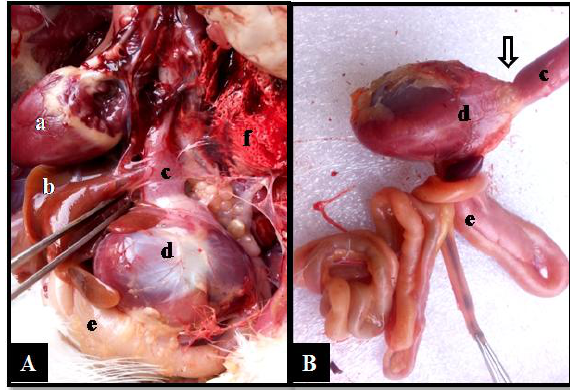
Figure, 1: A. Viscera of pigeon in situ the heart (a), Liver (b), proventriculus (c), ventriculus (d) duodenum (e). B. the isthmus (arrow).